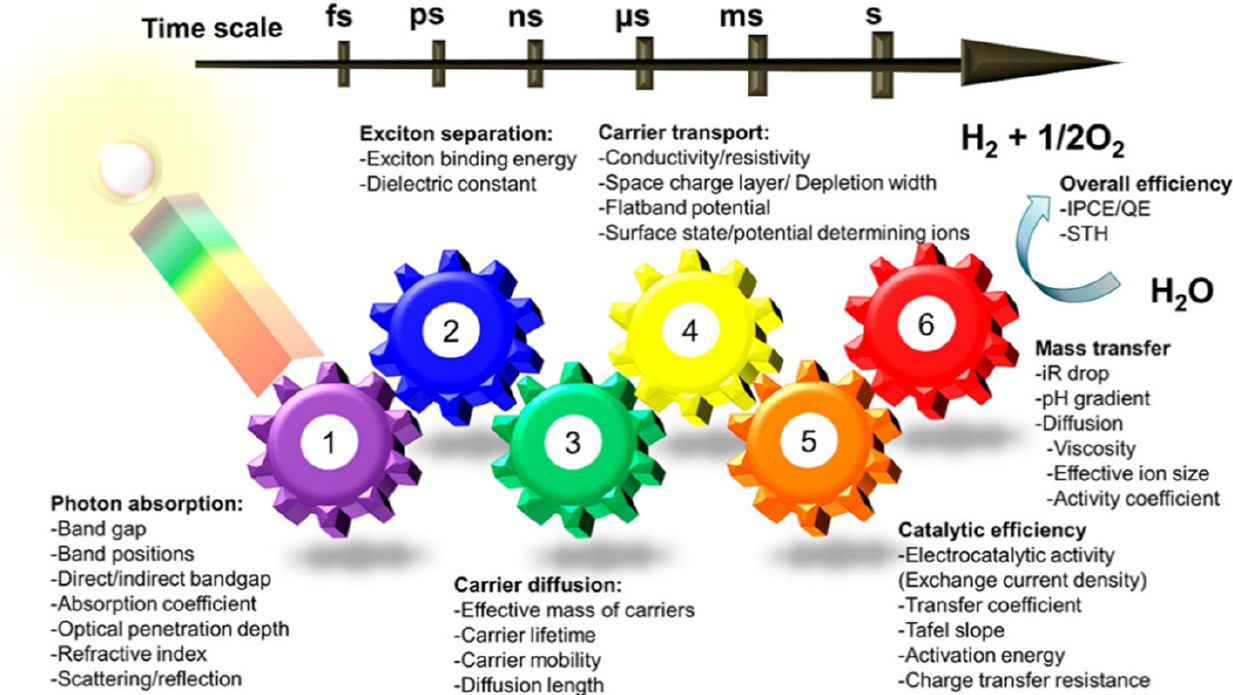
Figure 1. The parameters affecting the overall photocatalytic water splitting. The gear with the number indicates the order of the photocatalytic process to be successful for overall water splitting. The timescale for the reactions is also shown. Reprinted with permission from Ref [3], Copyright © 2017 American Chemical Society.